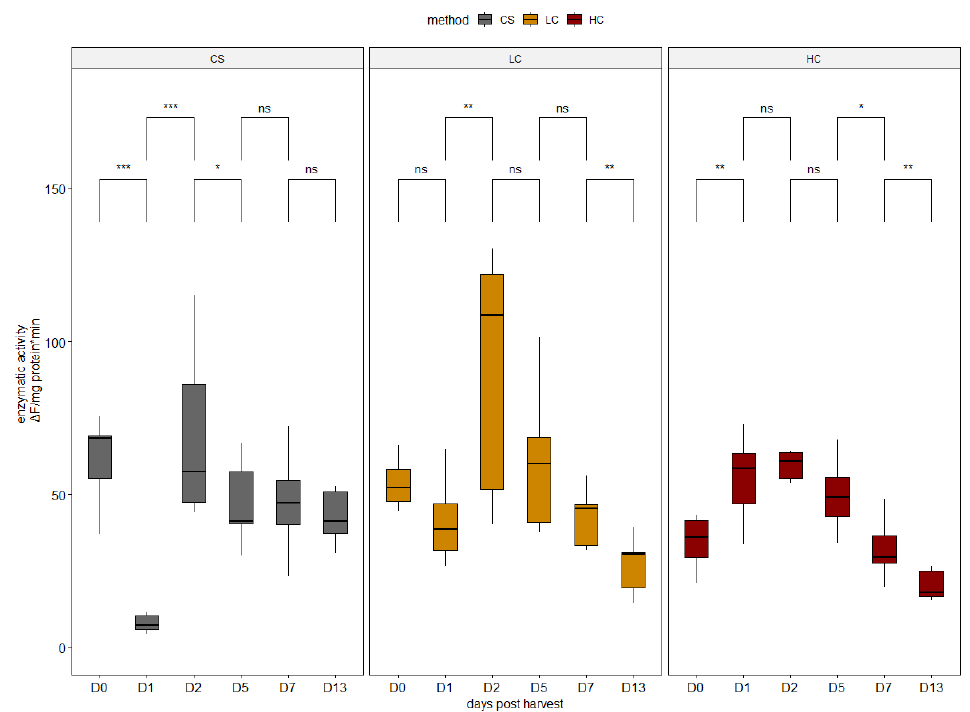
Figure 4. Enzymatic activity of cathepsin B in all sampling days per harvest method. CS (gray): control group, LC (orange): low current group, HC (red): high current group. Superscripts indicate statistically significant differences between days in each harvest method (ns: p > 0.05, *: p < 0.05, **: p < 0.01, ***: p < 0.001).